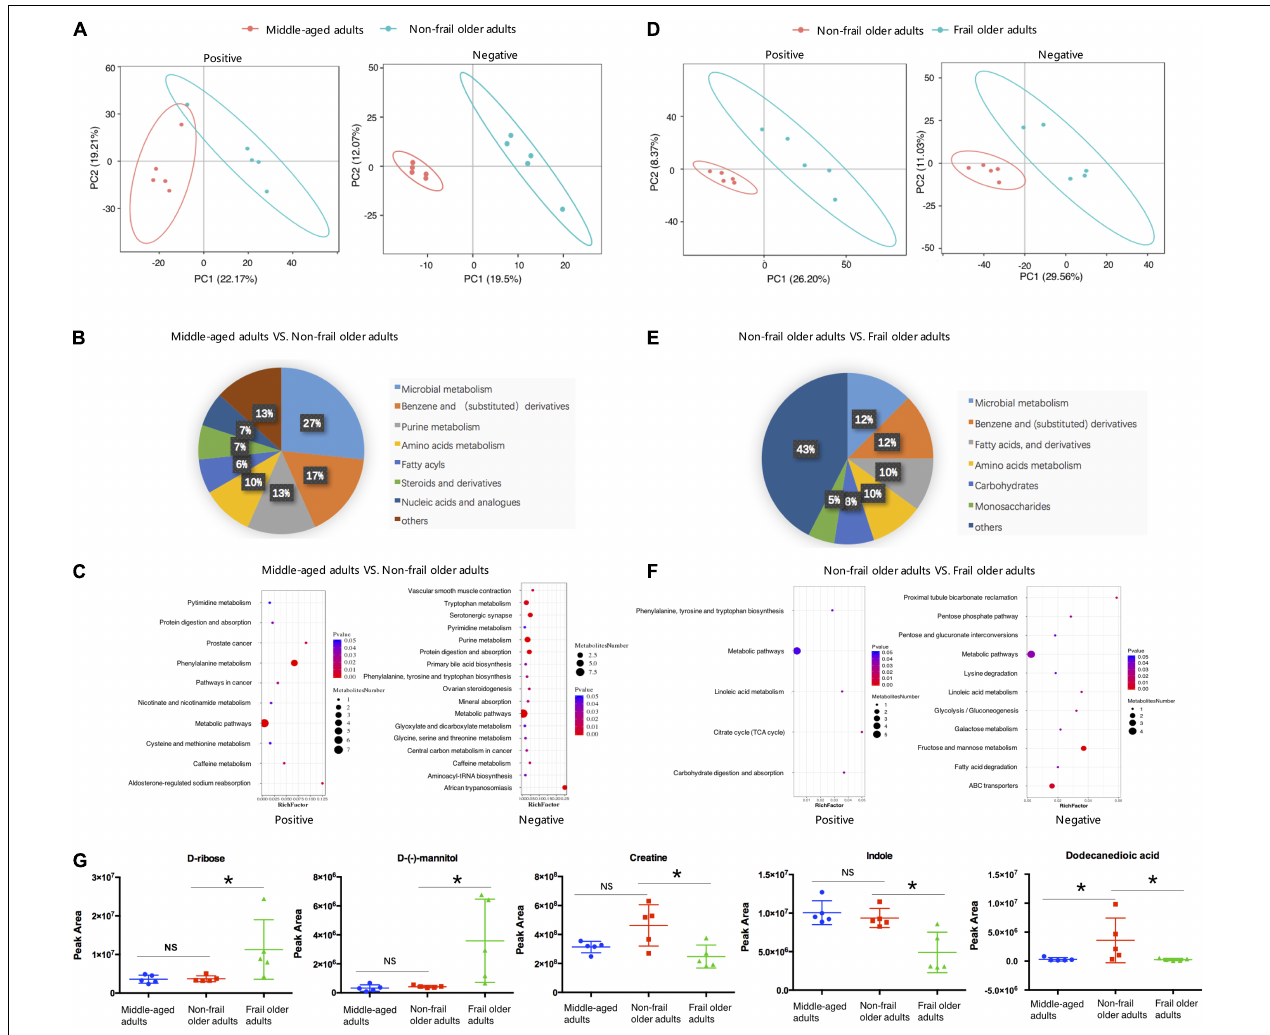
FIGURE 2 | Serum metabolome analysis. (A,D) PLS-DA analysis of the grouped discrimination by the first two principal components (PCs) in positive (pos) and negative (neg) ion modes. (B,E) Pie graph of the metabolite class composition of significantly altered metabolites according to the number of metabolites in serum. (C,F) Bubble chart of pathway enrichment analysis of differential metabolites in positive (pos) and negative (neg) ion modes. RichFactor was the number of differential metabolites divided by all the identified metabolites annotated to the pathway. (G) Relative abundance of the representative differential metabolites. Peak area: relative concentrations of metabolites. * p < 0.05. Error bars represented mean ±